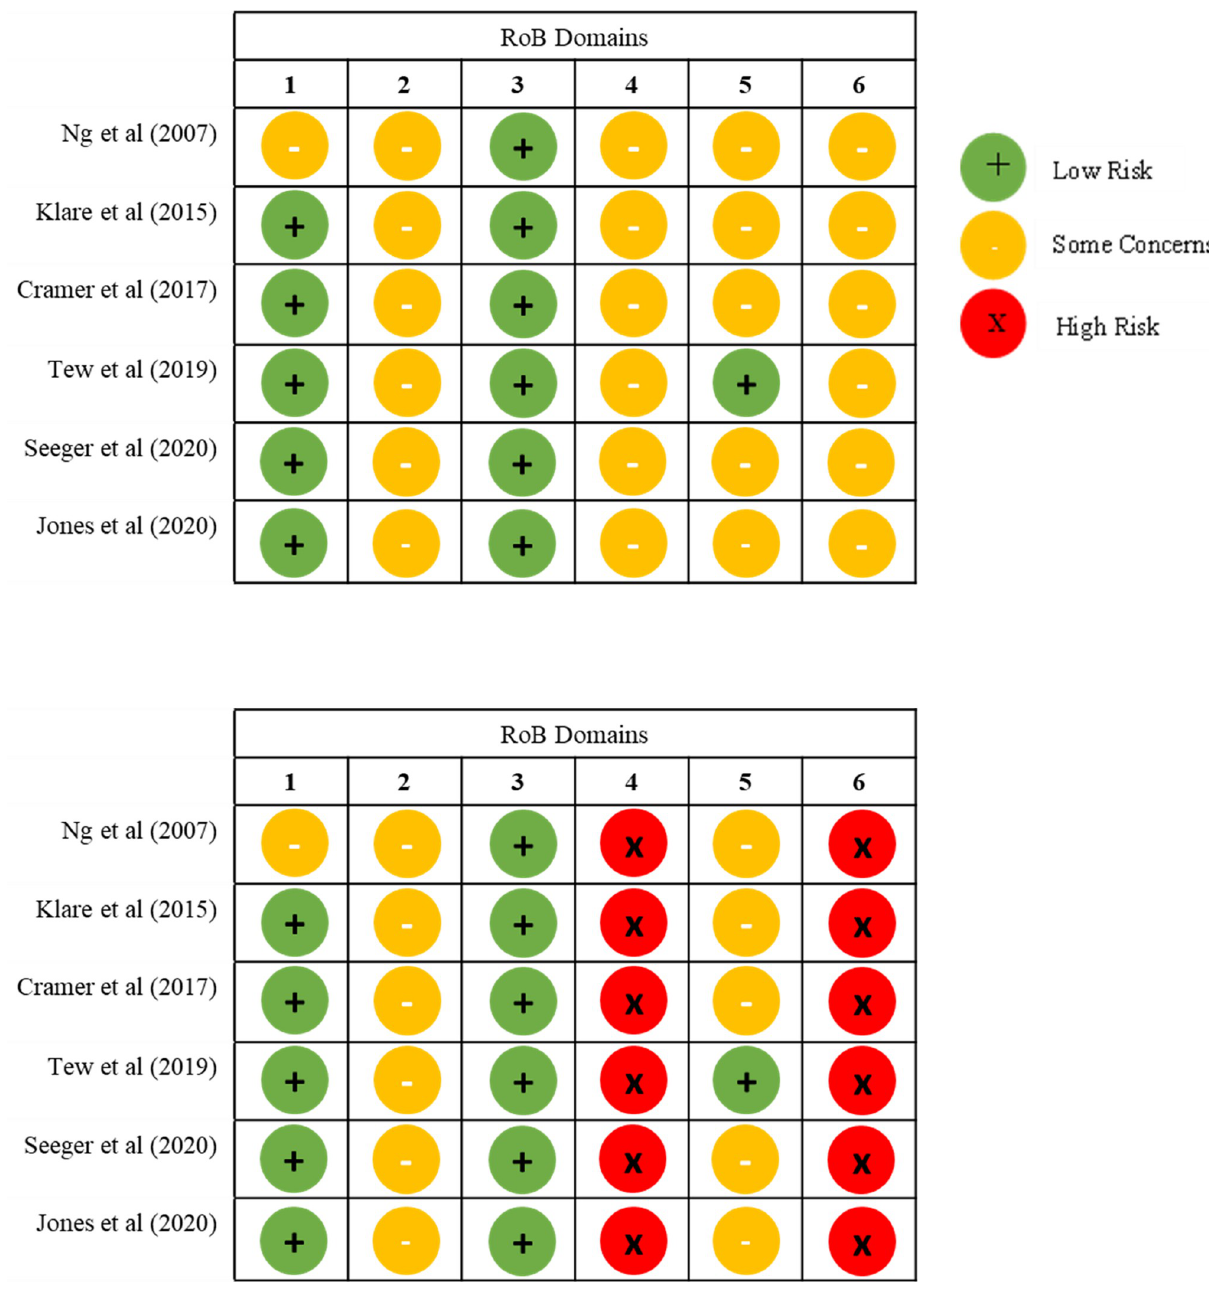
Fig 4. Risk of bias graph (A) disease activity, (B) health-related quality of life for meta-analysis. RoB 2.0 Tool Domains: 1) Bias arising from the randomisation process; 2) Bias due to deviations from intended interventions; 3) Bias due to missing outcome data; 4) Bias in measurement of the outcome; 5) Bias in selection of the reported result; 6) Overall